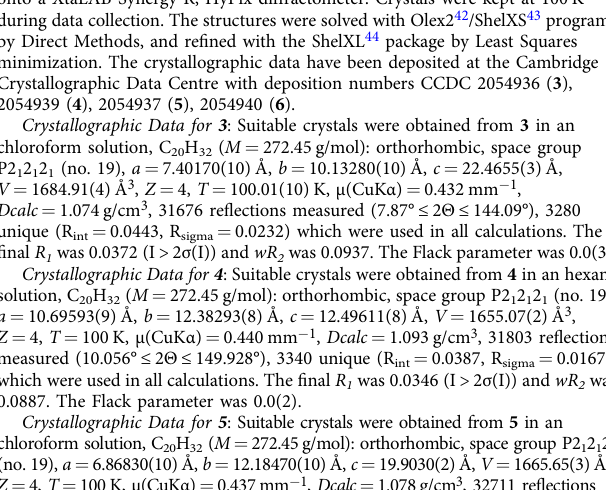
(Table S5) and 13 C NMR data (Table S6) with authentic data published before 39,40 . Compound 9 was isolated as a colorless oil. EIMS analysis afforded an M + ion at